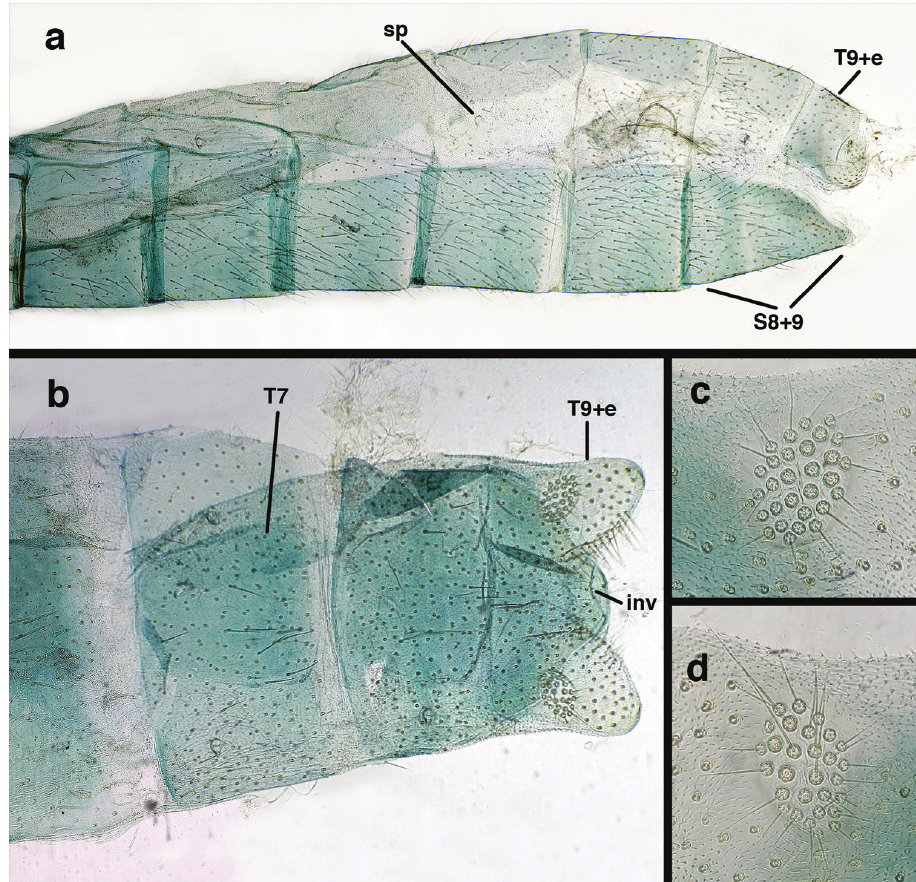
Figure 135. Ungla ivancruzi Freitas: Male abdomen, ( a ) segments A3-terminus, lateral ( b ) segments A7- terminus, dorsal [Note shallow invagination.] ( c, d ) callus cerci, showing variation in shape. inv invagina- tion in T9+ectoproct sp spiracle S8+9 fused eighth and ninth sternites T7 seventh tergite T9+e fused ninth tergite + ectoproct (Brazil, Minas Gerais, from original type series or their offspring, MJMO; images FS).